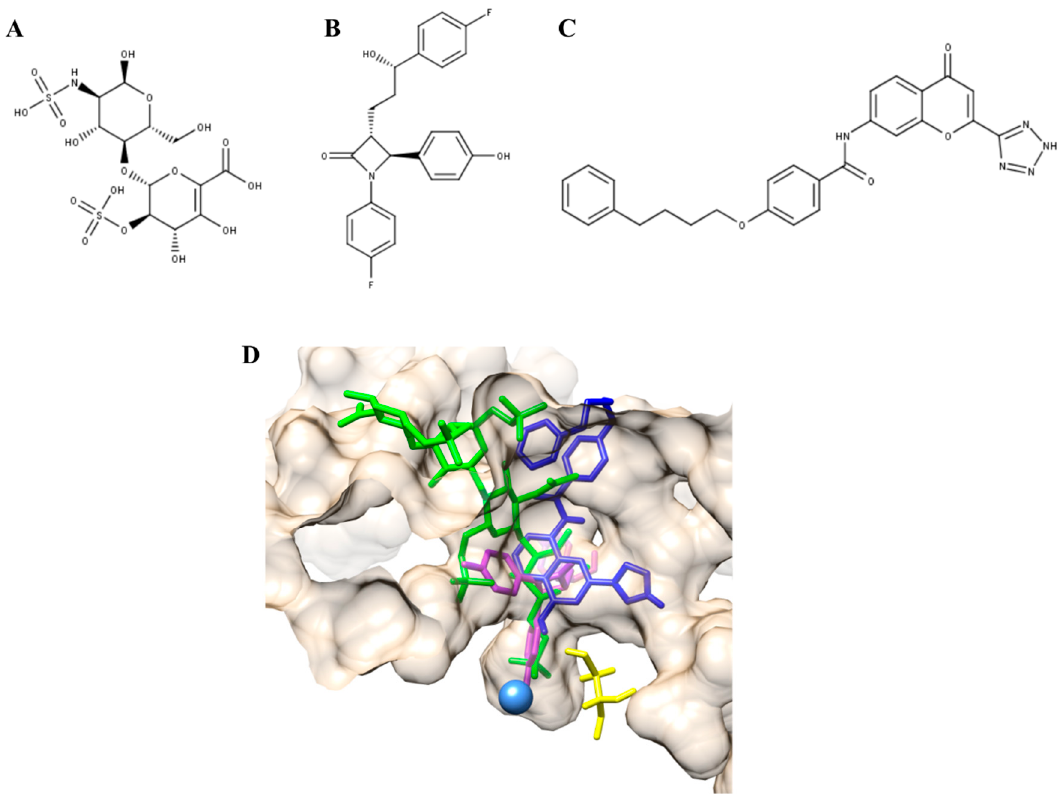
Figure 1. Pharmacological chaperones (PCs) for MPS II and MPS IVA. ( A ) Δ -unsaturated 2-sulfouronic acid-N-sulfoglucosamine (D2S0), ( B ) ezetimibe, and ( C ) pranlukast have been described as PC for ( A ) MPS II and ( B , C ) MPS IVA. ( D ) PC for MPS IVA were predicted to stablish similar interactions to those predicted for the natural and artificial N-acetylgalactosamine-6-sulfate sulfatase (GALNS) substrates. Green, KS; magenta, ezetimibe; blue, pranlukast. The catalytic residue (C79) and calcium ion are colored in yellow and light blue, respectively.